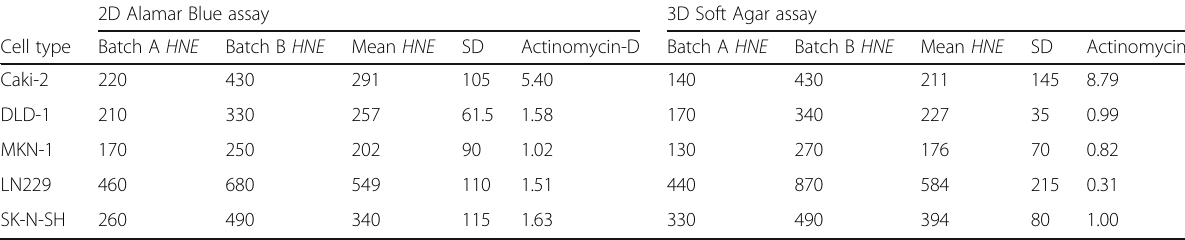
Table 2 IC 50 concentrations ( μ g/ml) of HNE in the 2D Alamar Blue assay and 3D Soft Agar assay 2D Alamar Blue assay 3D Soft Agar